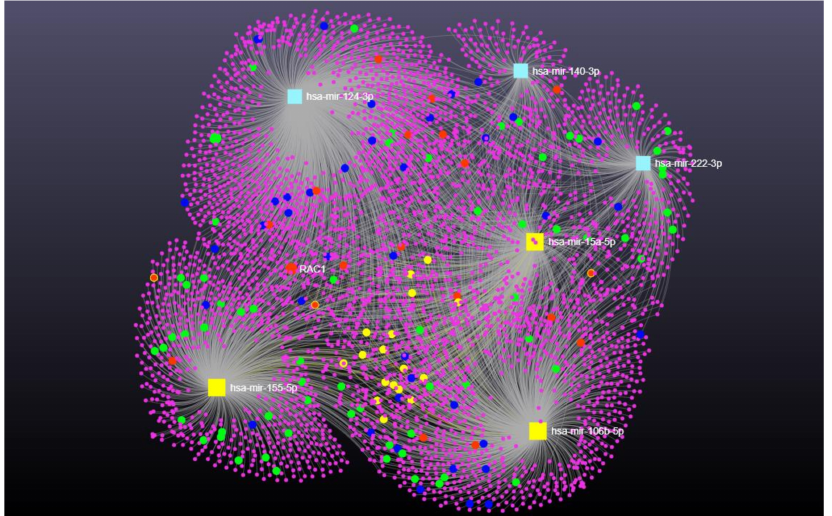
Figure 3. Network visualization for the enrichment analysis of miR-155-5p, miR-15a-5p, miR124- 3p, miR-222-3p, miR-140-3p, and miR-106b-5p in GRN and C9ORF72 FTD group. Yellow squares represent miRNAs, and pink circles are their targets. In particular, yellow circles represent the shared interactions. Phagosome and regulation of autophagy target genes are represented in red, axon guidance pathway in blue, and RNA degradation and transport are highlighted in green.